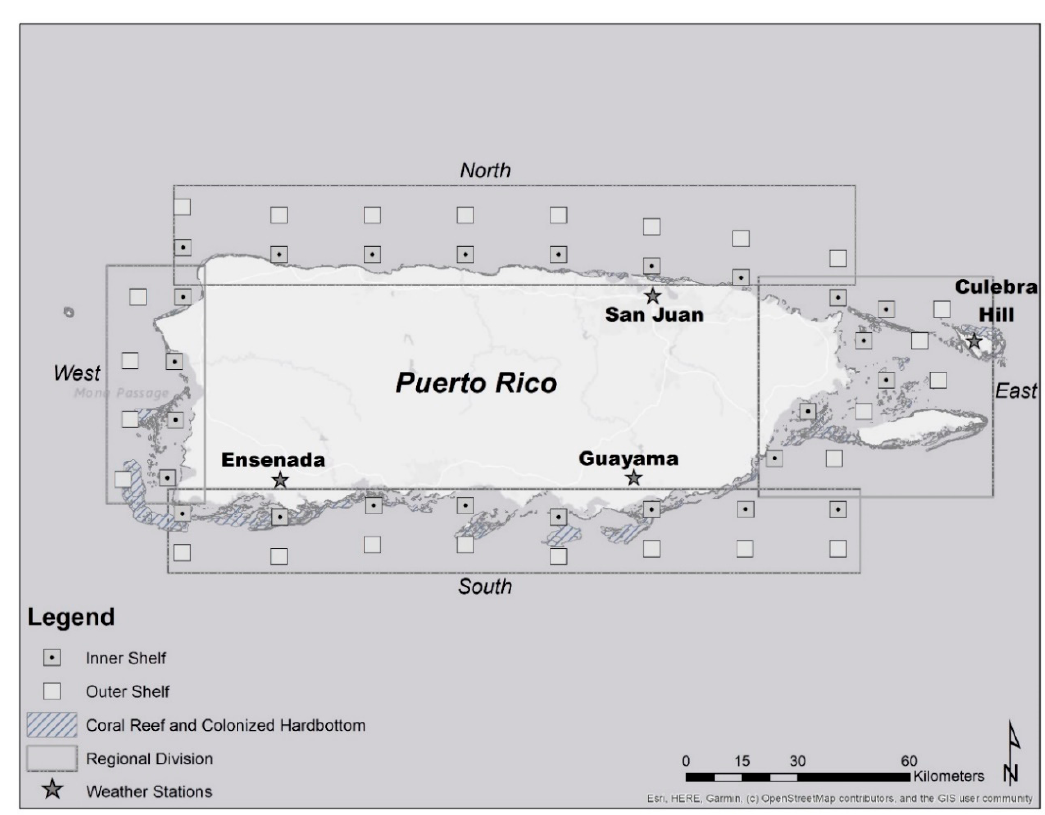
Figure 2. VIIRS satellite map of monthly mean chlorophyll- a (Chl- a ) concentration during September 2017.